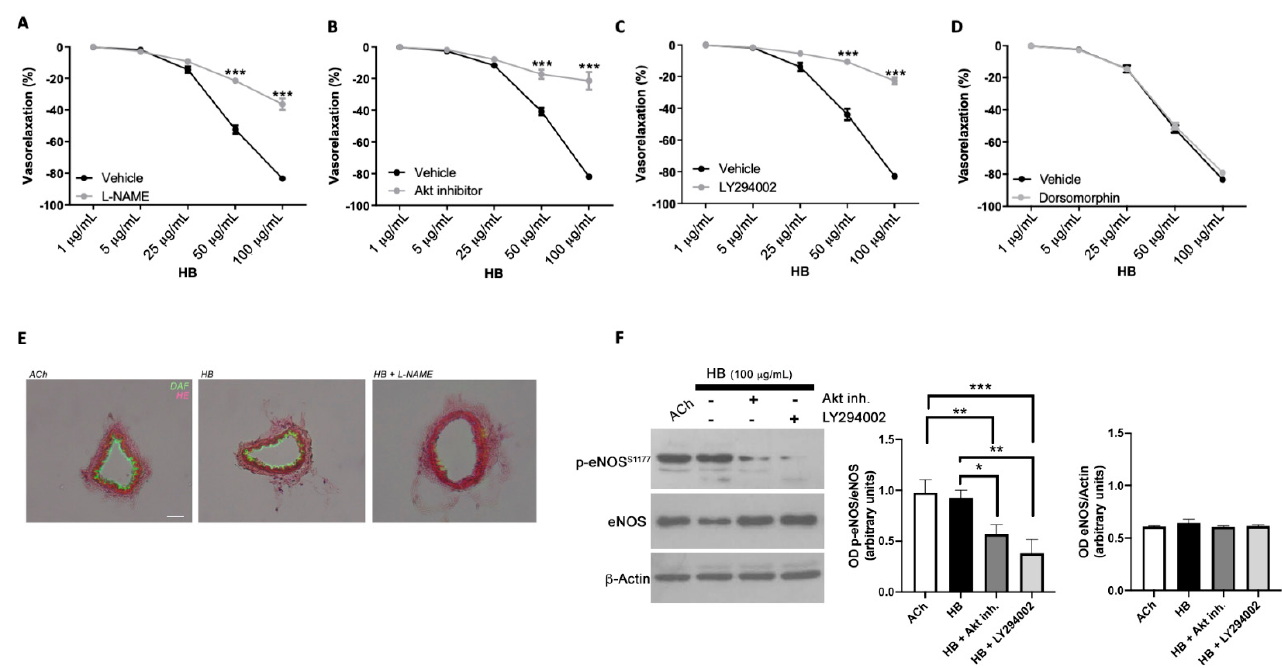
Figure 2. ( A – D ) Vascular response of phenylephrine-precontracted mice mesenteric arteries to increasing doses of HB in the presence of ( A ) L-NAME ( N = 7), ( B ) Akt inhibitor ( N = 7), ( C ) in the presence of PI3K inhibitor (LY294002) ( N = 7), or ( D ) in the presence of AMPK inhibitor (dorsomorphin) ( N = 5). ( E ) Representative high-power micrographs of 10 µm sections of mice mesenteric arteries loaded for 2 h with 4,5-diaminoflfluorescein (DAF-FM) reveal nitric oxide production after treatment with acetylcholine (Ach 10 − 6 M) or HB (50 µg/mL) and after 30 min of pretreatment with L-NAME (300 µmol/L), counterstained with haematoxylin and eosin (HE). Scale bar, 50 µm. ( F ) (left): representative immunoblots of mice mesenteric arteries treated with HB (100 µg/mL) alone, or HB plus Akt inhibitor or LY294002; (right): semiquantitative analyses, columns are the mean ± SEM of three independent experiments. * p < 0.05; ** p < 0.01, *** p < 0.001.